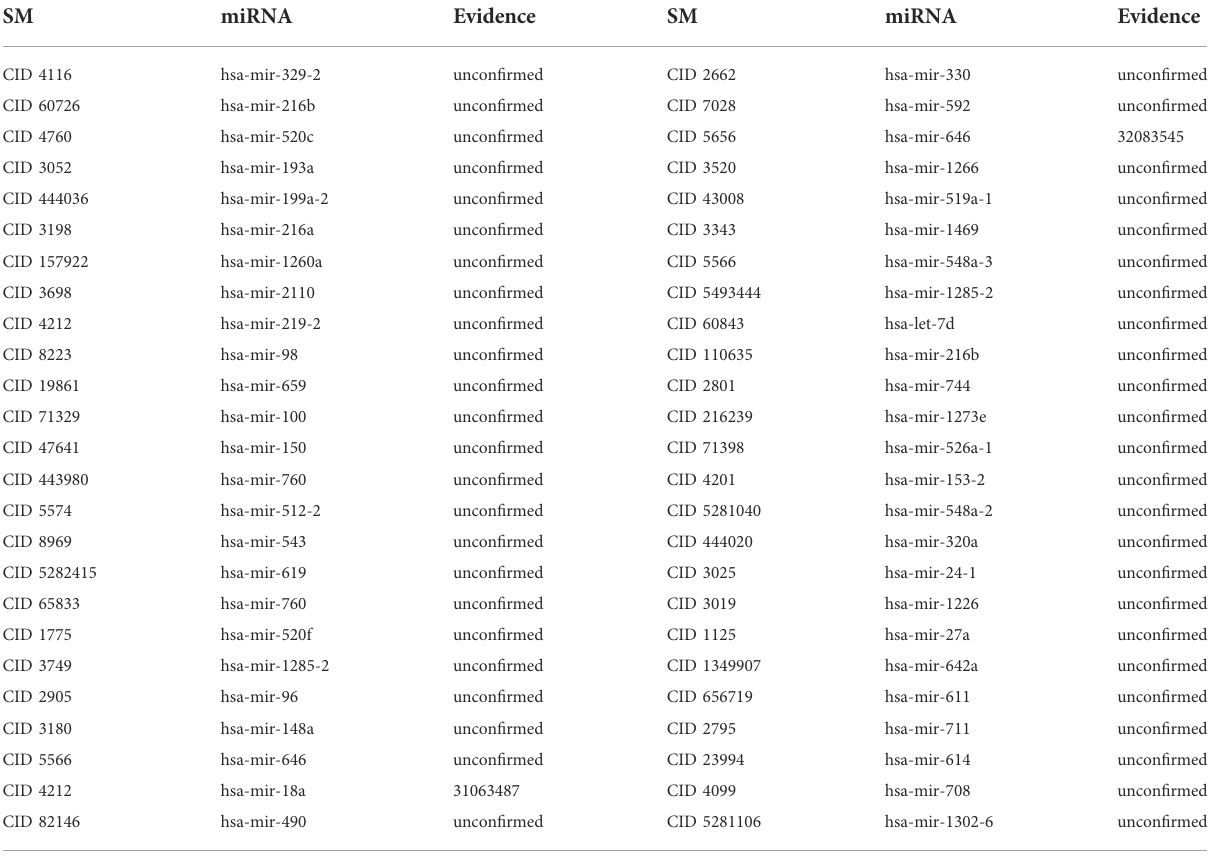
TABLE 2 Validation of the random 50 SM-miRNAs associations. The fi rst column records the random 1 – 25 associations. The second column records the random 26 – 50 associations.